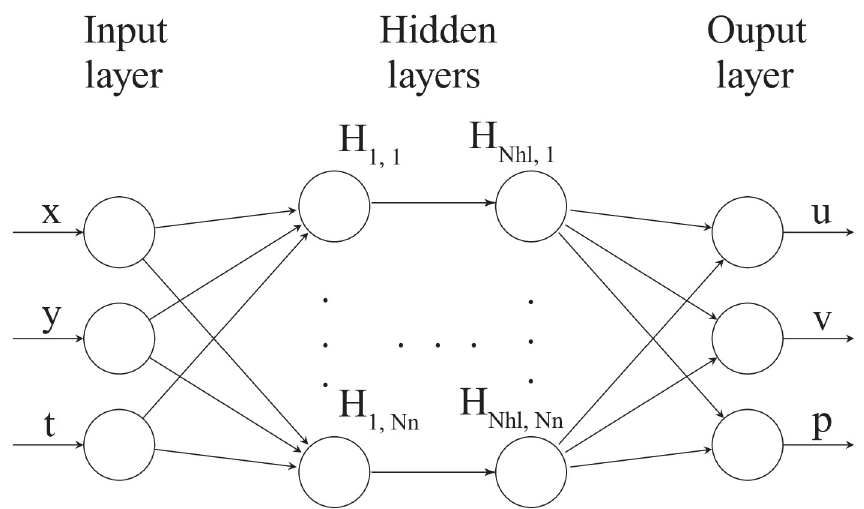
Fig 7. Neural networks architecture used for nonlinear Biot’s equations. This figure corresponds to the top part of Fig 3. There are three inputs, x , y , and t , and three outputs, u , v , and p . The number of hidden layers, N hl , and the number of neurons for each hidden layer, N , denote the n